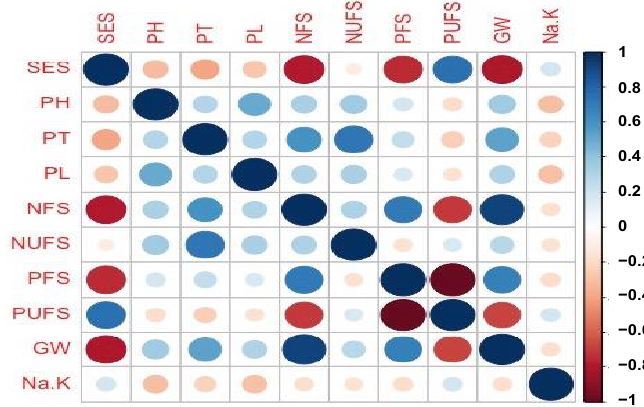
Figure 2. Correlation coefficients for grain yield and agronomic components of BC 1 F 2 individuals from Hasawi × BRRI dhan28 under salinity stress of 10 dS/m at the reproductive stage of rice plant.